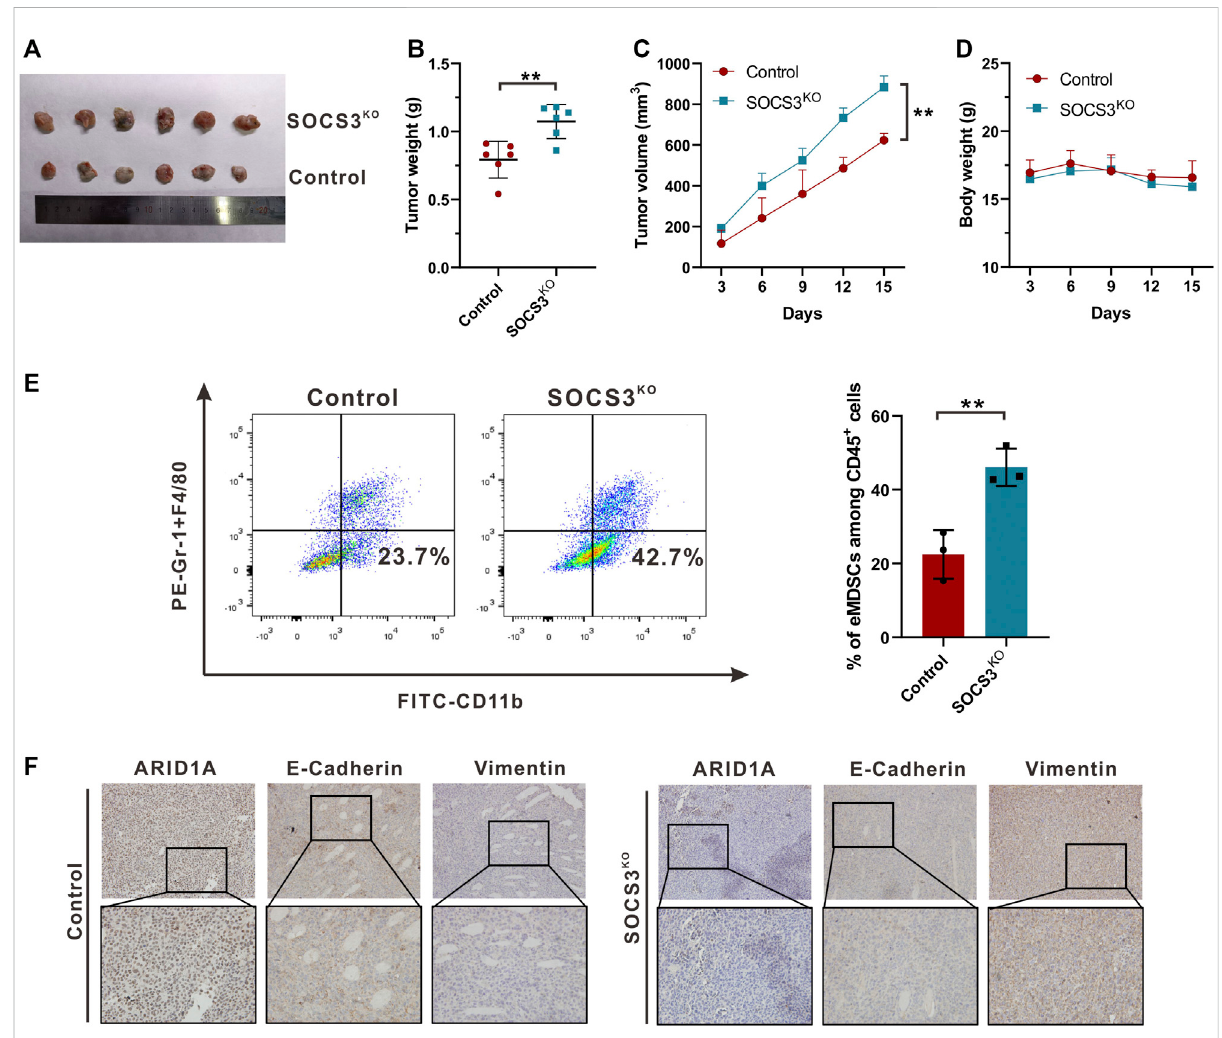
FIGURE 6 eMDSCs promote tumor growth via accelerating EMT process (A) Representative images for xenografts model in SOCS3 fl / fl and SOCS3 KO mice. (B,C) TheweightandvolumeoftumorsintheSOCS3 KO groupweresigni fi cantlygreaterthanthoseinthecontrolgroup. (D) Therewasnodiscernible change in body weight between the SOCS3 KO group and the negative control group. (E) The percentages of eMDSCs were detected by FCM in primary tumor tissues. (F) The images show immunohistochemistry staining for ARID1A, E-Cadherin, and Vimentin in xenografts. * p < 0.05, ** p <